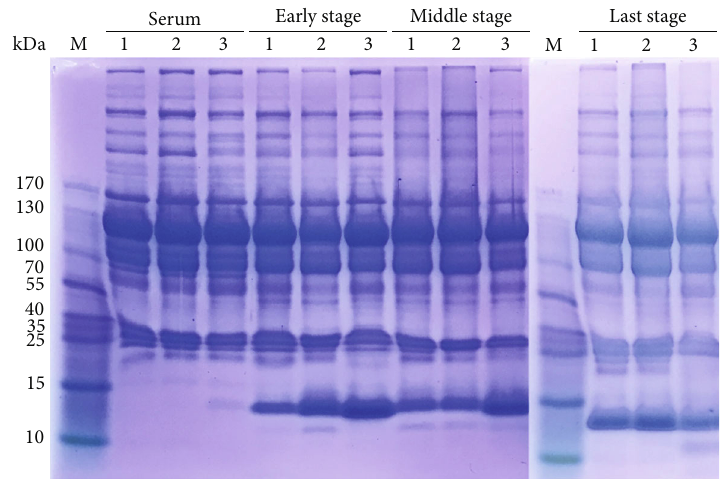
Figure 3: SDS-PAGE separation of serum and exudate protein at di ff erent treatment